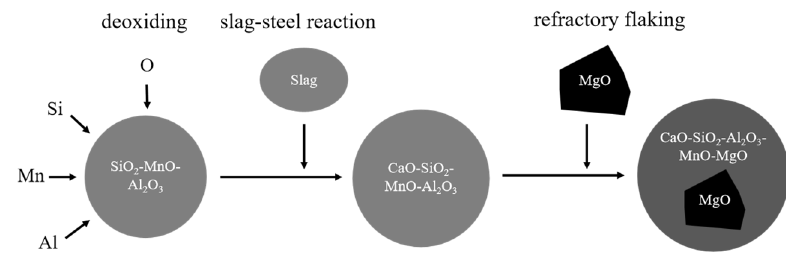
Figure 14. Schematic diagram of MgO-based inclusion evolution mechanism.